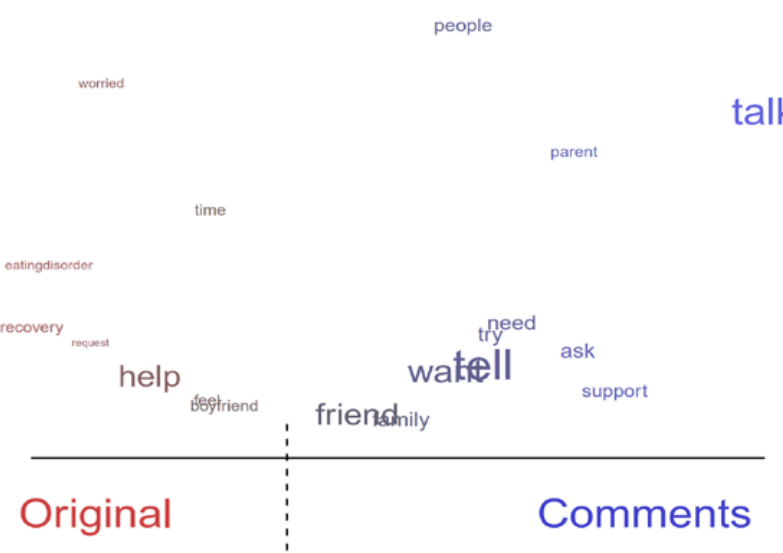
Figure 2. Difference in topic content between original threads and comments (health issue: Topic 7).